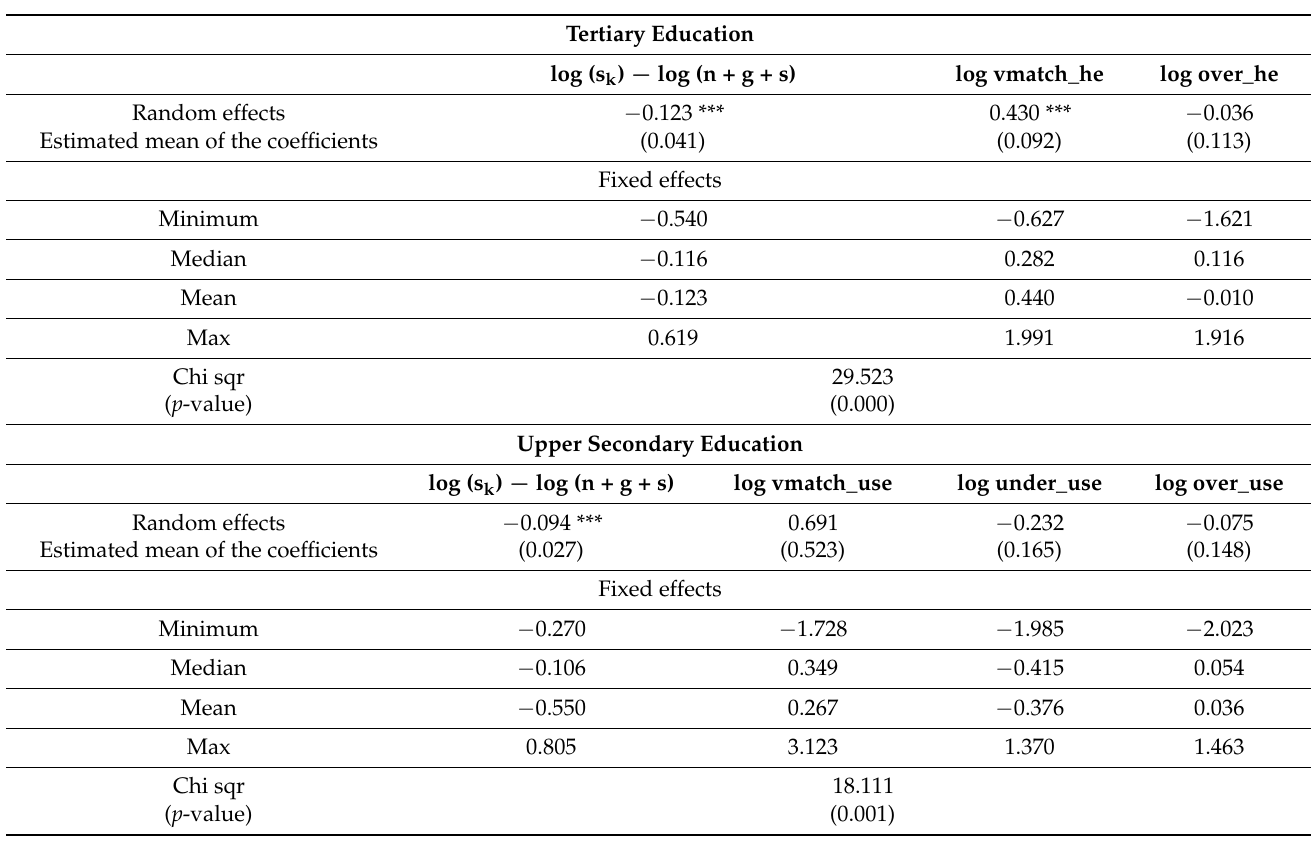
Table 6. Robustness checks: variable coefficients